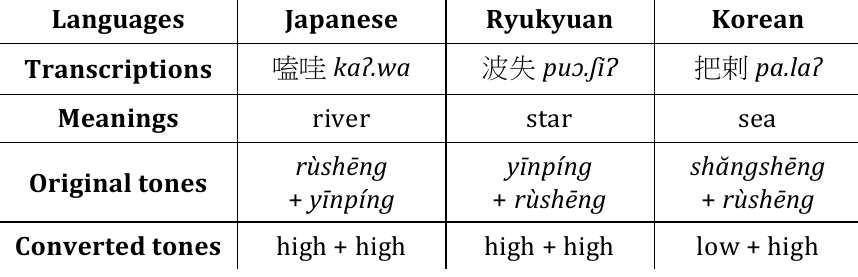
Table 8: Examples of transcribing prosody in the three historical